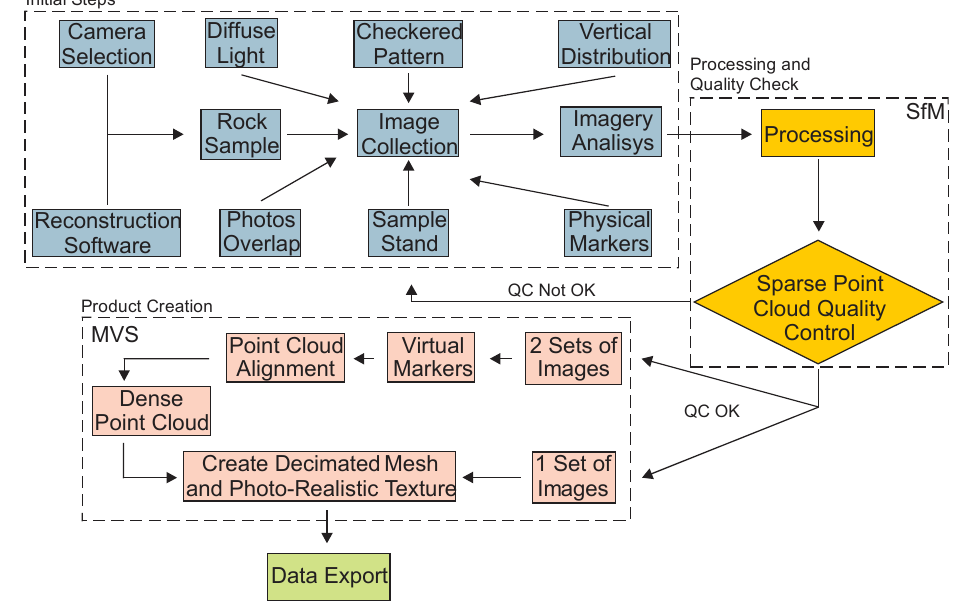
Figure 6. Proposed Methodology Workflow.